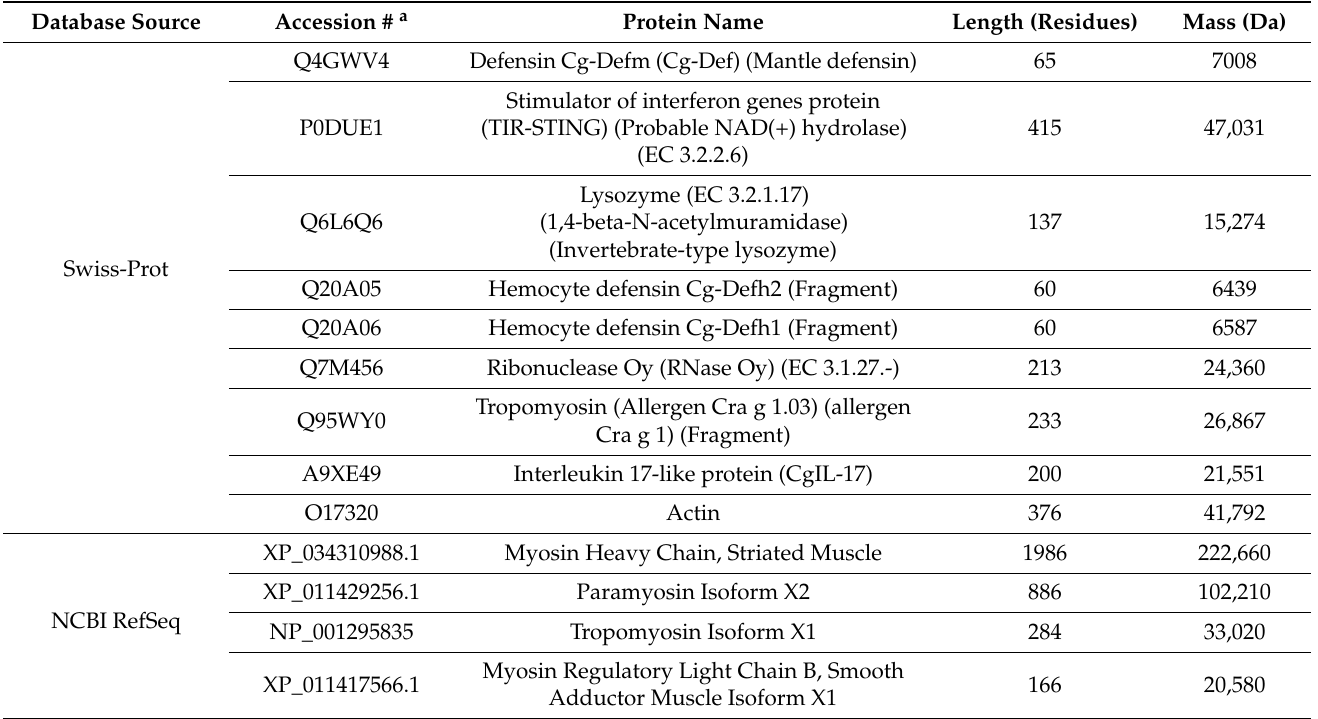
Table 6. Full list C. gigas proteins selection for